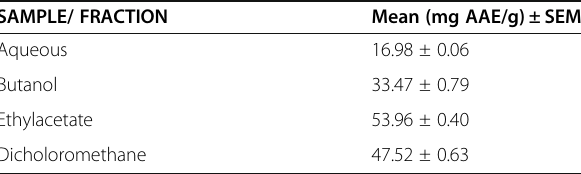
Table 5 Ferric reducing antioxidant power (FRAP) activities of different solvent fractions of P. guineense